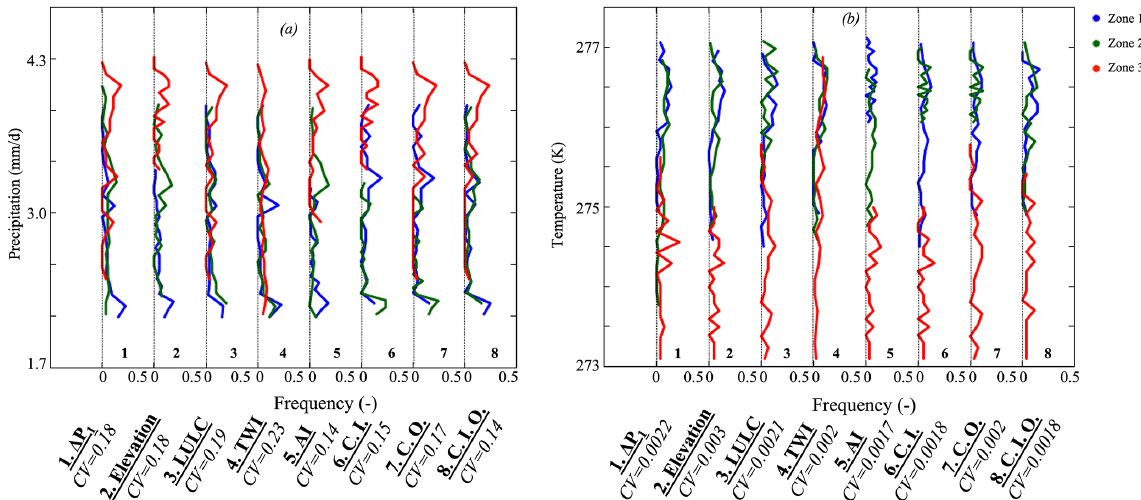
Figure 7. Frequency distributions of hillslope (a) annual average daily rates of precipitation and (b) annual average temperature. Clustering approaches are based on (cid:49)P 1 , elevation, land cover (LULC), topographic wetness index (TWI), aridity index (AI), and machine-learning approaches (with inputs C.I., outputs C.O., and inputs and outputs C.I.O.). Hillslope clustering approaches are located across the x axis. Note that we plotted the distributions of the eight clustering approaches on the same graph, and between each dotted line (with a frequency from 0 to 0.5), the frequency distributions of the three zones derived from the clustering are